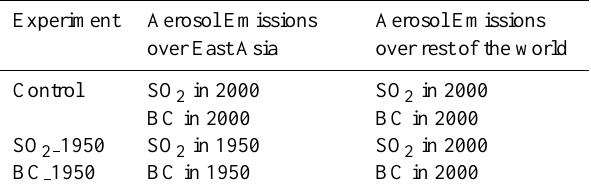
Table 1. Summary of aerosol emissions used in experiments.